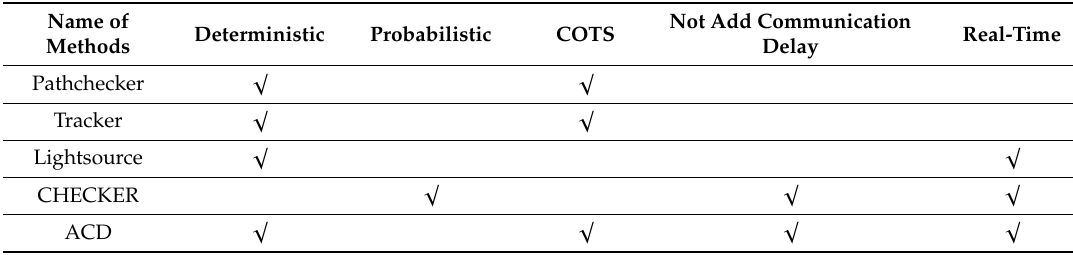
Table 3. Comparison of clone detection